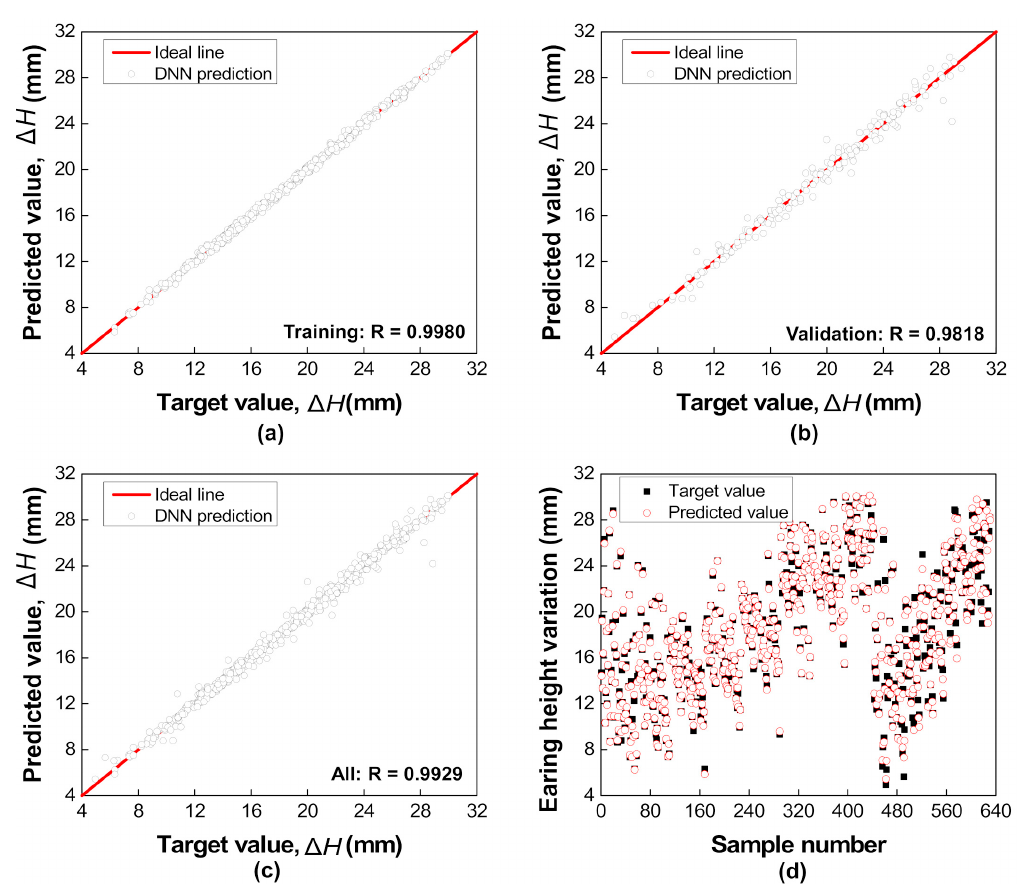
Figure 13. DNN model prediction with coefficient of determinations for ( a ) training, ( b ) validation, ( c ) all, and ( d ) compared results between the target and predicted earing height variation.